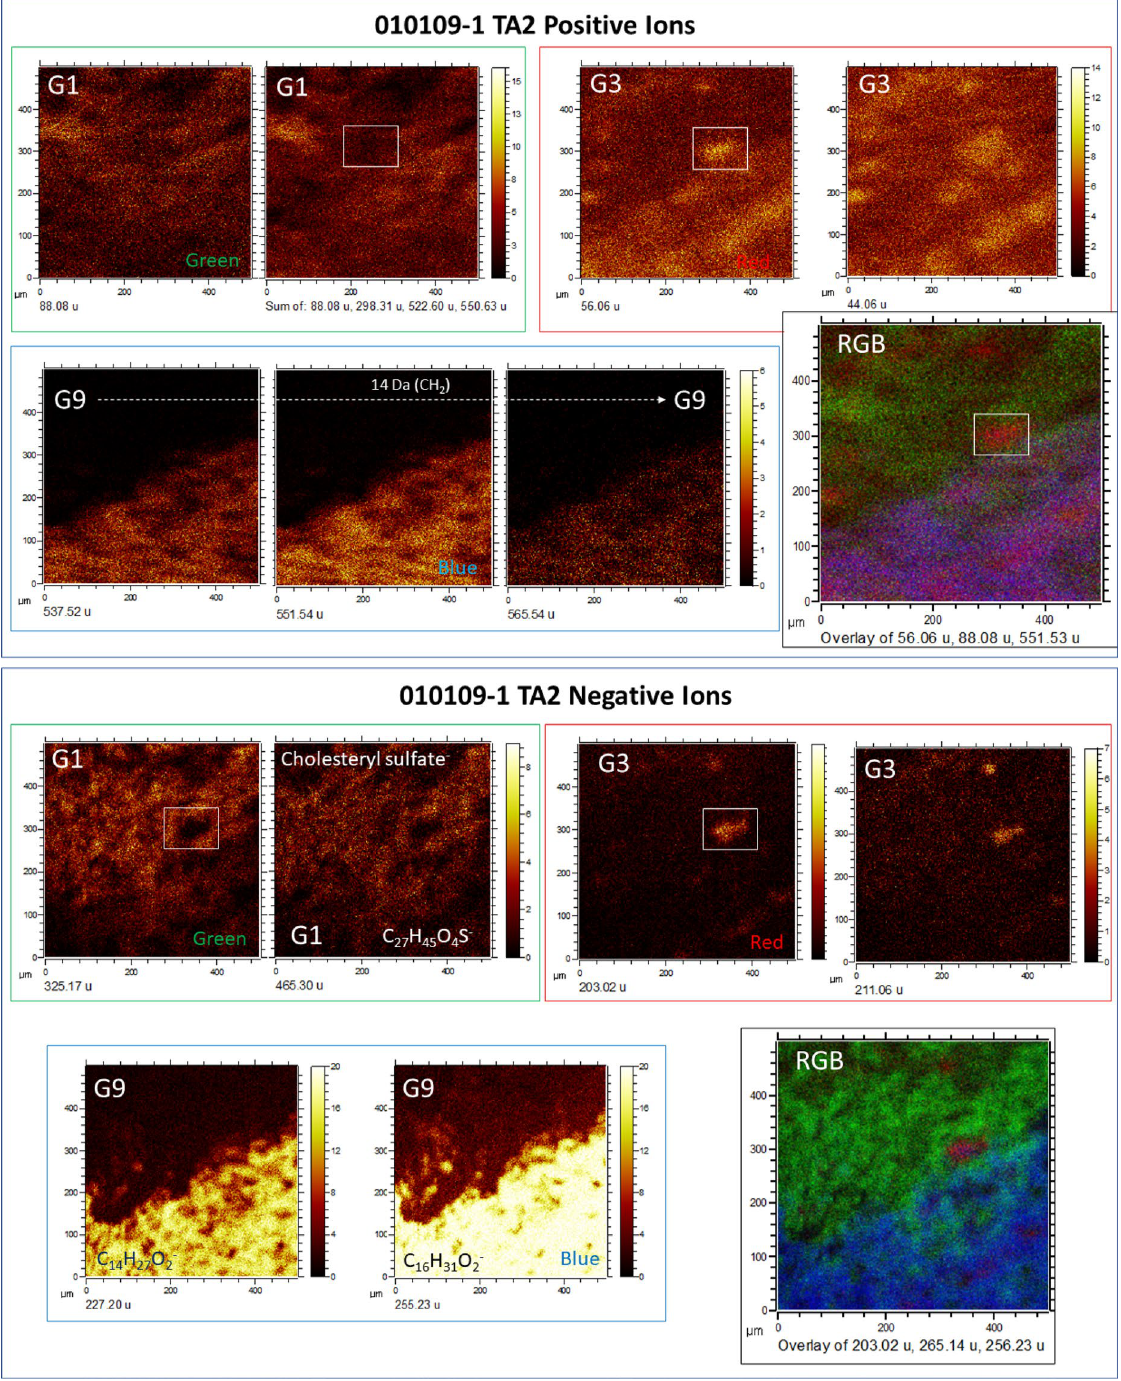
Figure 6. Characterization of possible microbial structures preserved in Target Area 2 (TA2) by using the ToF–SIMS molecular mapping capabilities. The image analysis follows the same morphological groups G1 to G8 adding one new group G9. Two different main structures defined by G1 and G9 are limited by a sharp boundary between them. The G1 microstructure is characterized by a strong intensity of different N- and S-bearing compounds that outline a diffuse filament network, whose primary composition would be large lipids such as ceramides. However, G9 shows a more massive filamentous mass that is traced by a high intensity in acylglycerides and FA fragments. G3 occurs as an independent group of microstructures that interlock both G1 and G9 microstructures. The RGB overlay shows two main microbial structures (G1 and G9) in which empty cavities would be occupied by a third microbial unit defined by G3. Interestingly, the G1 microbial structure is strongly mineralized by sulfate while G3 and G9 microstructures are mineralized by ferruginous materials, suggesting that they were formed in two separate mineralization episodes. The microbial structure and composition of G1 and G9 suggest that these groups could correspond to mineralized